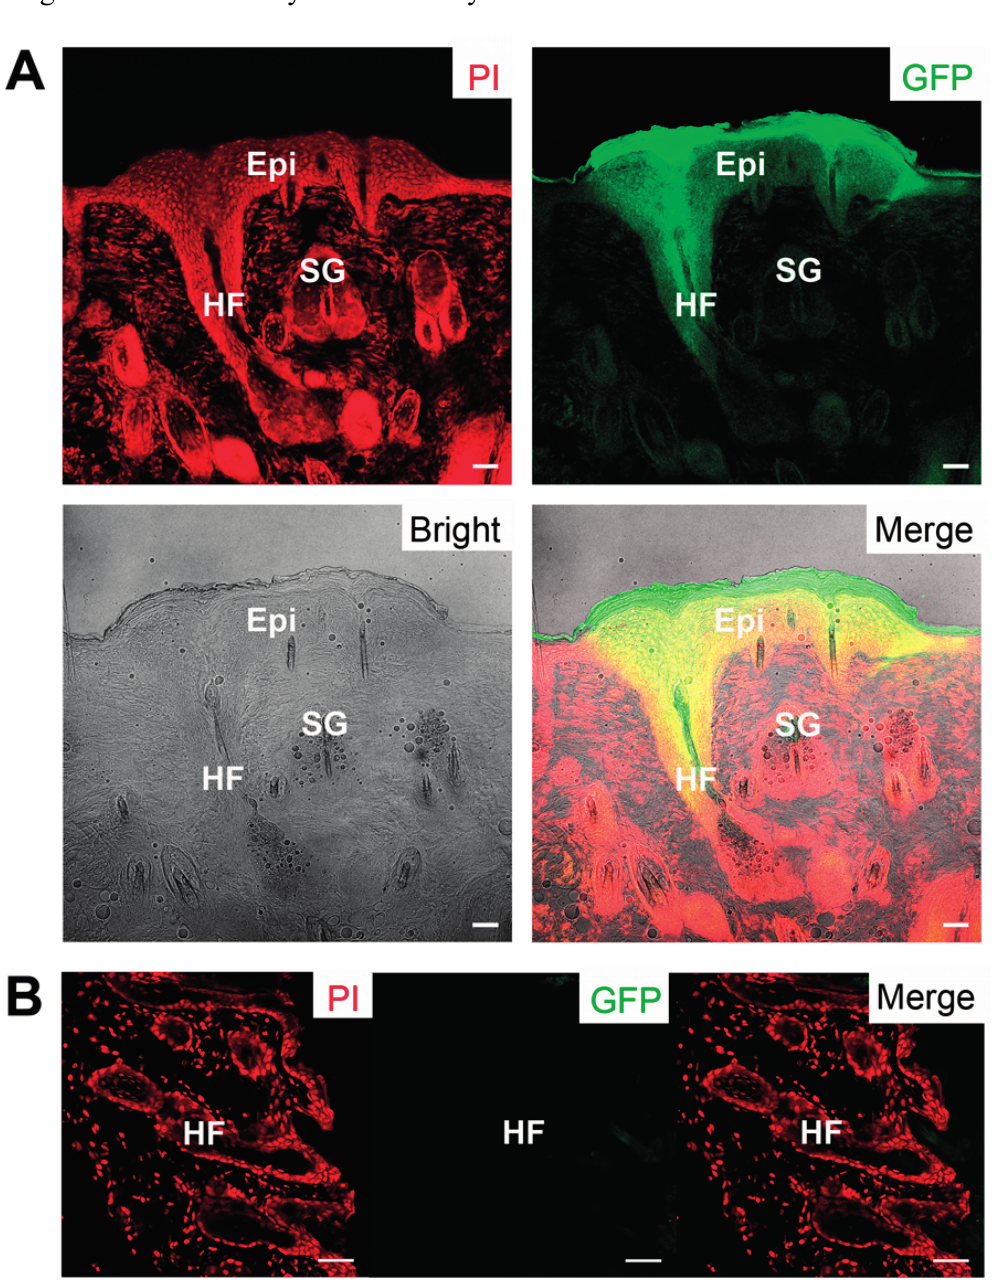
Figure 6. ( A ) The reconstituted hair follicles, multilayer epidermis, and sebaceous glands showing green fluorescence; ( B ) The native skin of the recipient nude mouse as a negative control without green fluorescence. Epi, epidermis; HF, hair follicle; SG, sebaceous gland. Scale bar, 50 μ